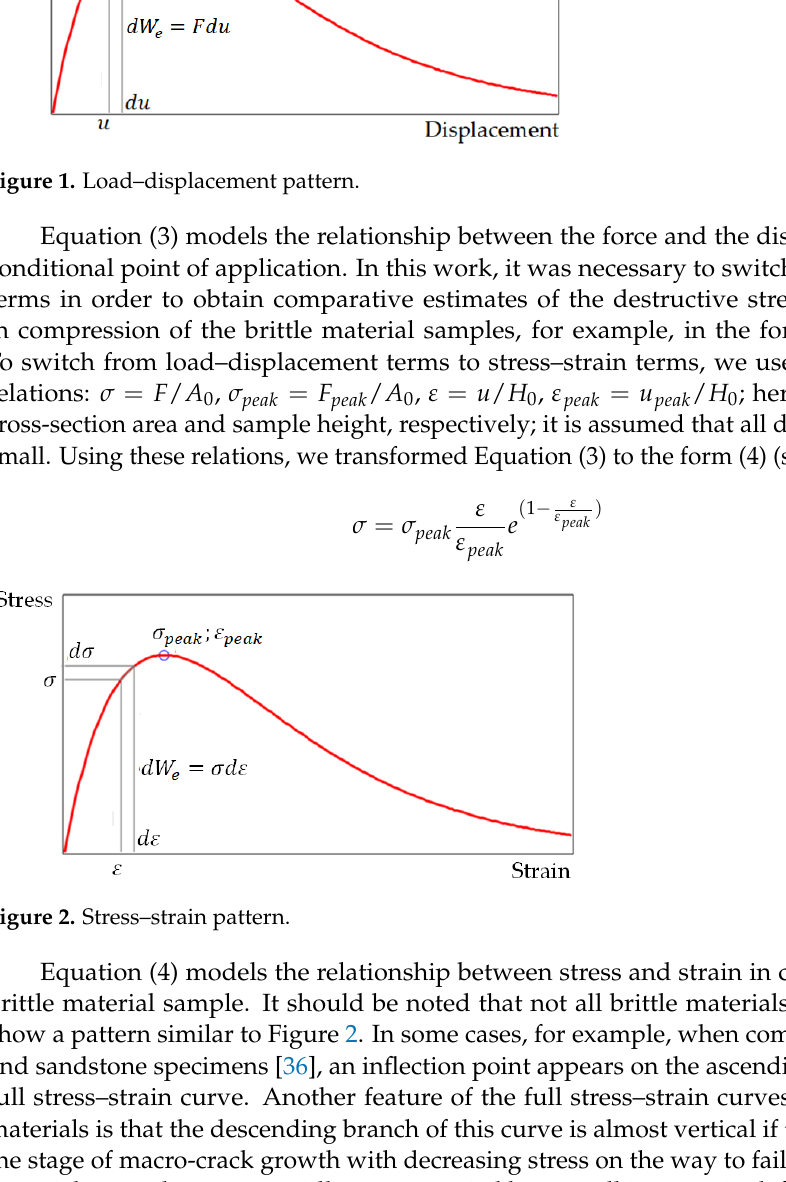
Figure 1. Load–displacement pattern.